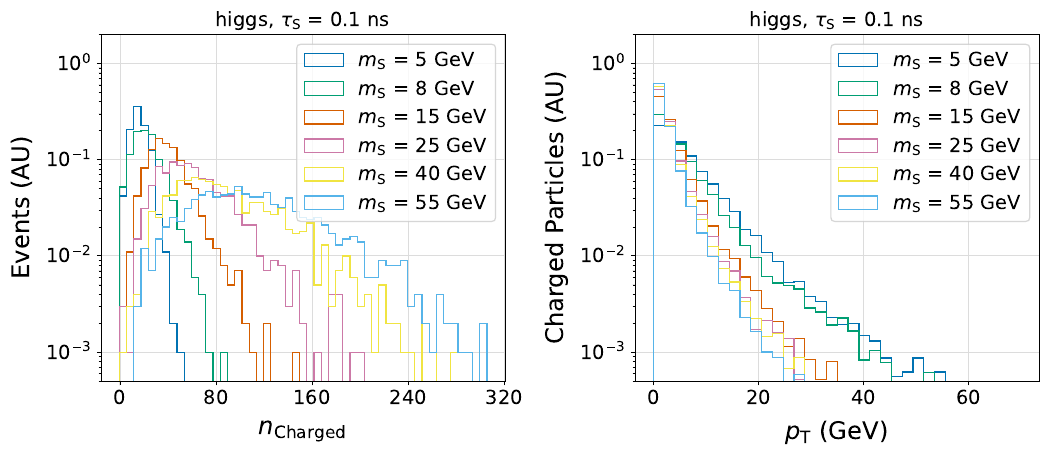
Figure 6. (Left) The number of displaced charged particles per event. Particles are required to be decay products of the long-lived scalar and have p p T for each scalar